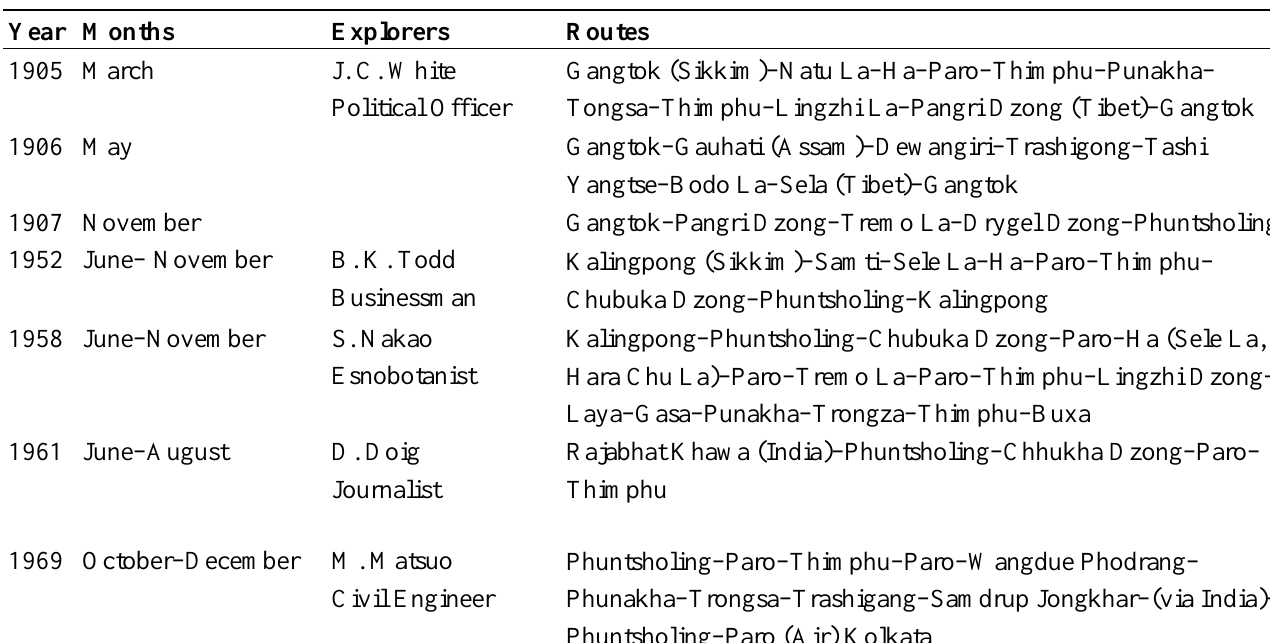
Table 1. Early visitors and their routes in